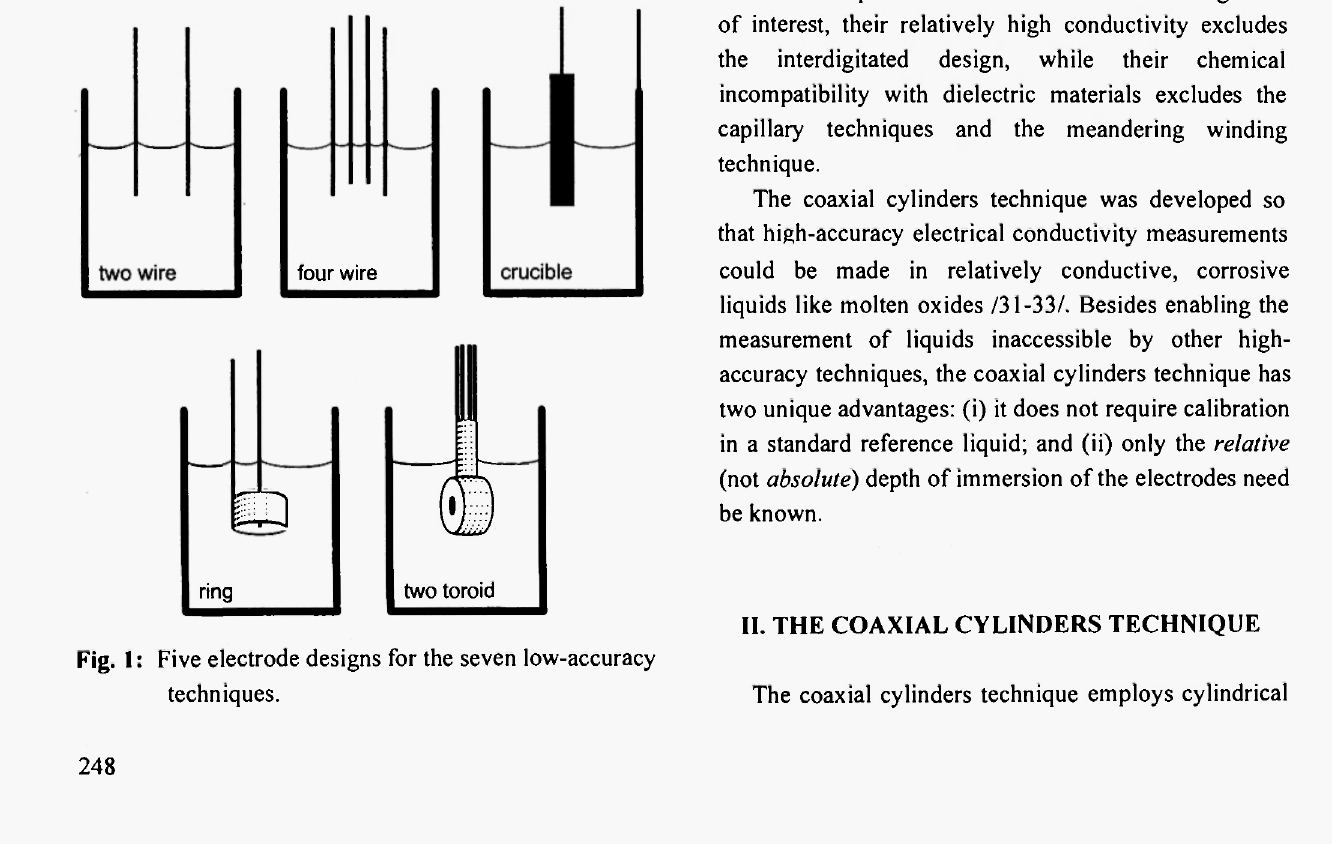
Fig. 1: Five electrode designs for the seven low-accuracy techniques.